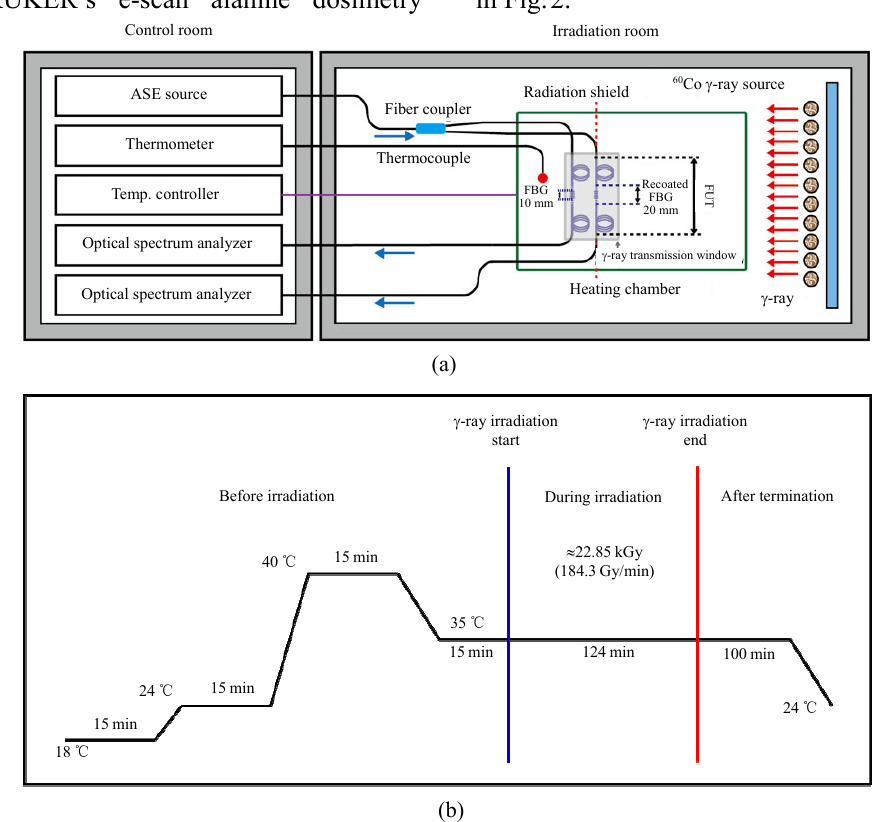
Fig. 2 RIA measurement of (a) the experimental setup upon the γ -ray irradiation and (b) the temperature profile with the events of the γ -ray irradiation during the